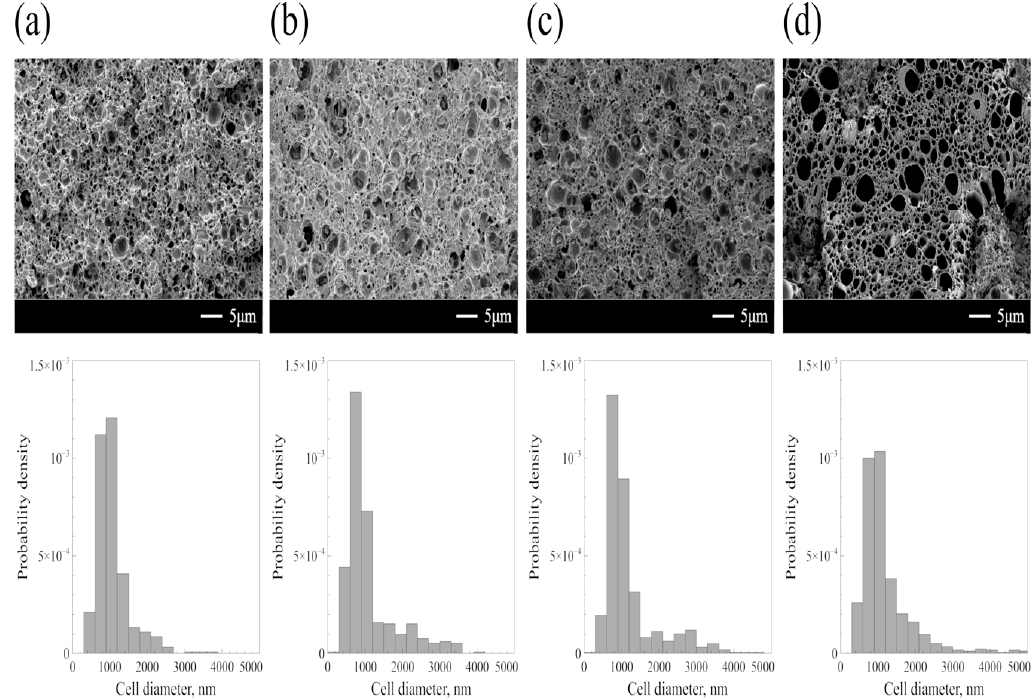
Figure 4. SEM images and the size distribution curves of ABS/R-PET blend foams. Samples were foamed at ( a ) 60 °C, ( b ) 80 °C, ( c ) 100 °C, and ( d ) 120 °C after sorption with CO 2 at − 20 °C, 10 MPa over a period of 24 h. The depressurization time was one second. The size distribution curves became